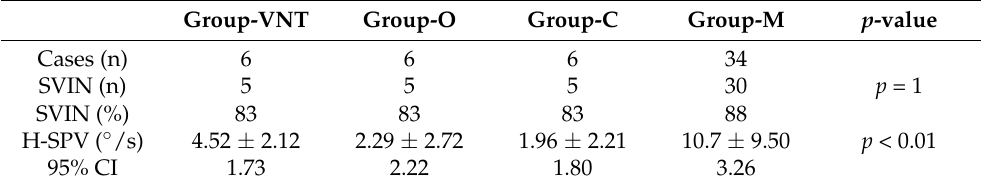
Table 2. SVIN presence and horizontal SPV value in the different groups N, C, O, M.